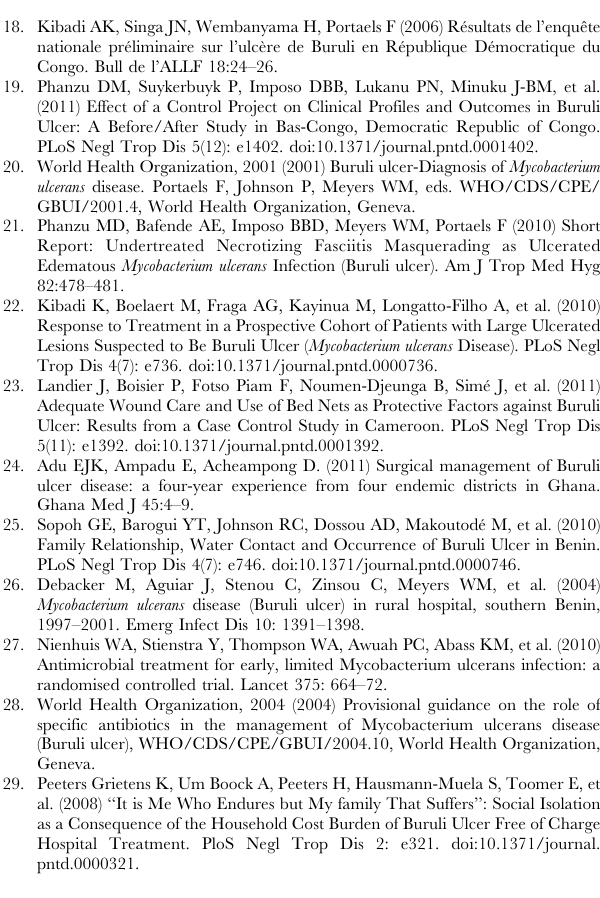
Table S2 Distribution of active and inactive BU cases in the Rural Health Zone of Nsona Mpangu (July–August 2008). Table S3 Comparison of active case features in the two Rural Health Zones of Songololo Territory, July–August 2008. Table S4 Comparison of inactive case features in the two Rural Health Zones of Songololo Territory, July–August